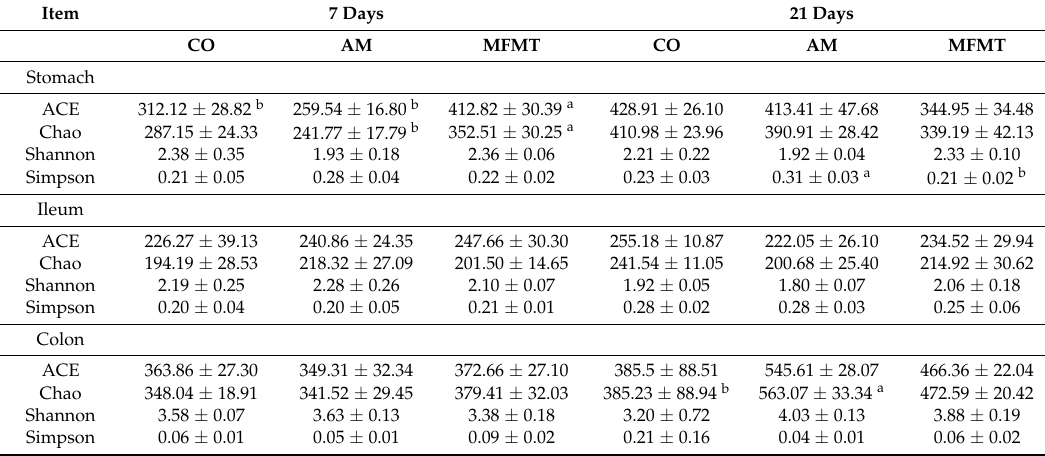
Table 1. Diversity estimation of the 16S rRNA gene libraries from microbiota in the stomach, ileum, and colon of piglets in the maternal fecal microbiota transplantation (MFMT), amoxicillin (AM), and control (CO) groups ( n =